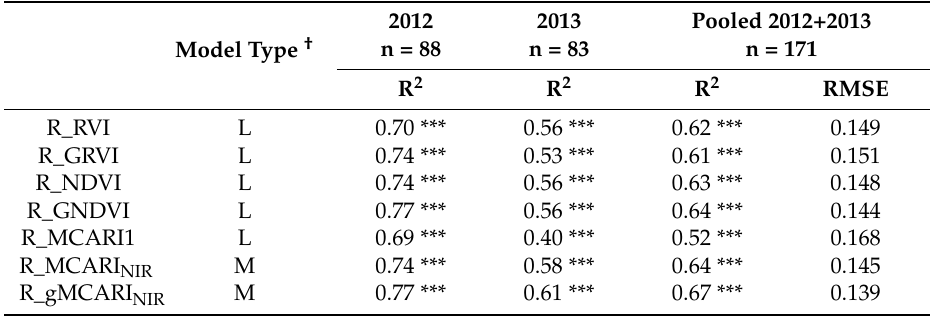
Table 4. Coefficients of determination (R 2 ) of the relationships between R_yield and R_VIs for years 2012 and 2013 and the pooled data, and RMSE for the pooled data.